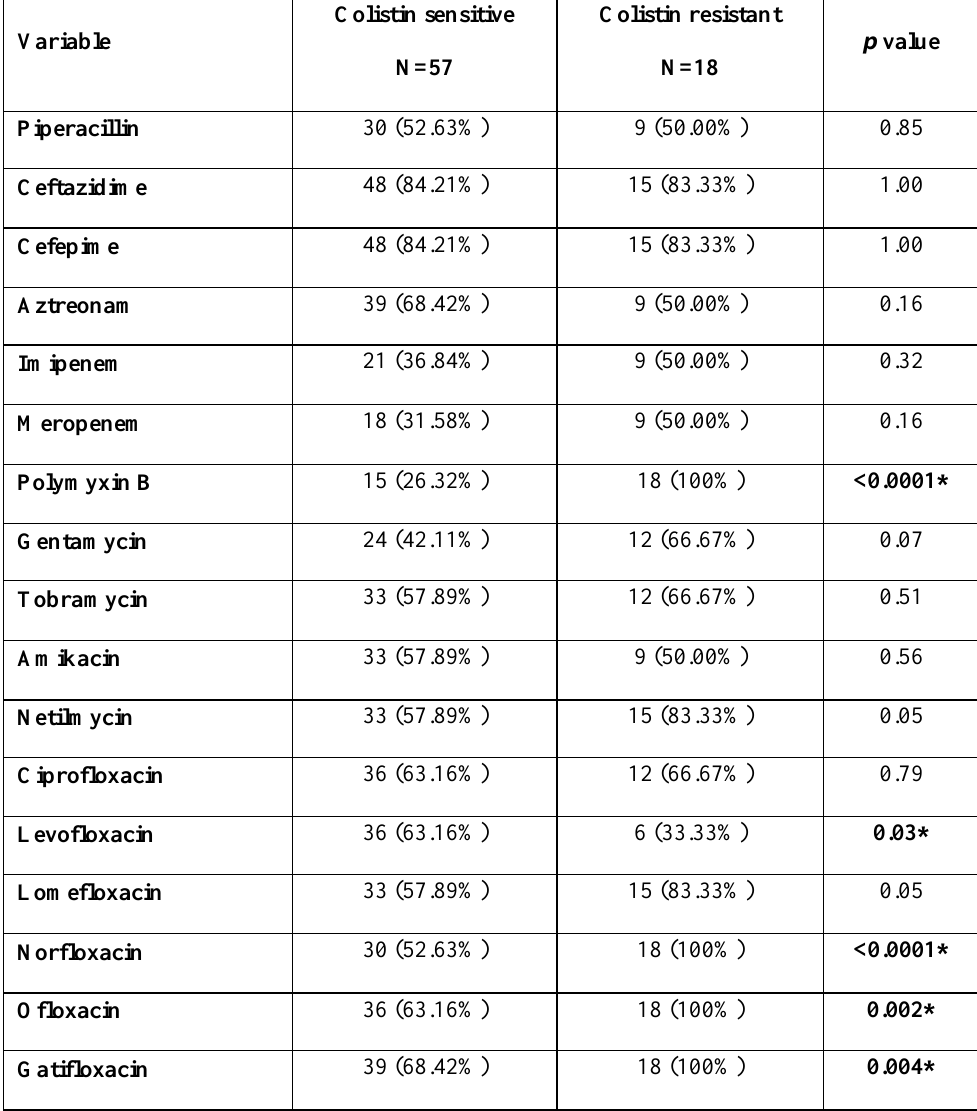
Table 5. antibiotic susceptibility profile of colistin-sensitive versus colistin-resistant isolates